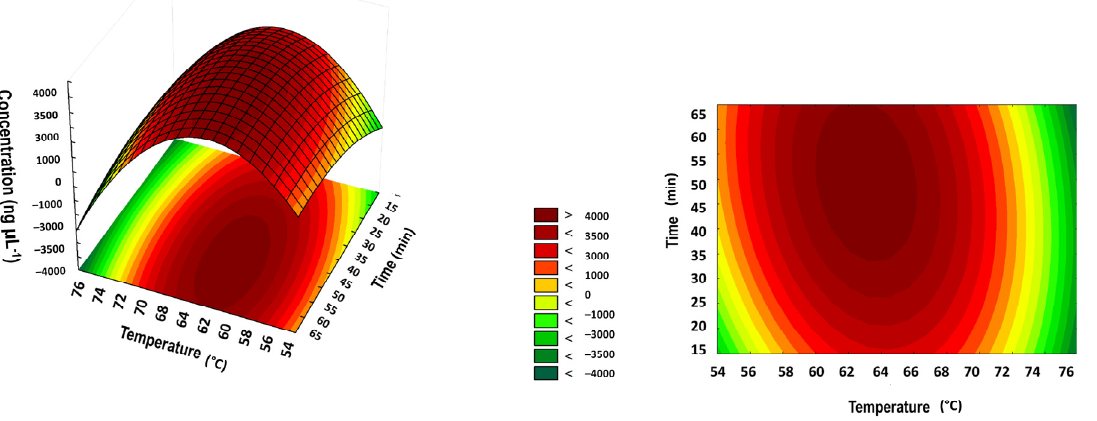
Figure 4. Response surface obtained from 11 experiments carried out according to the rotational central compound design (RCCD).